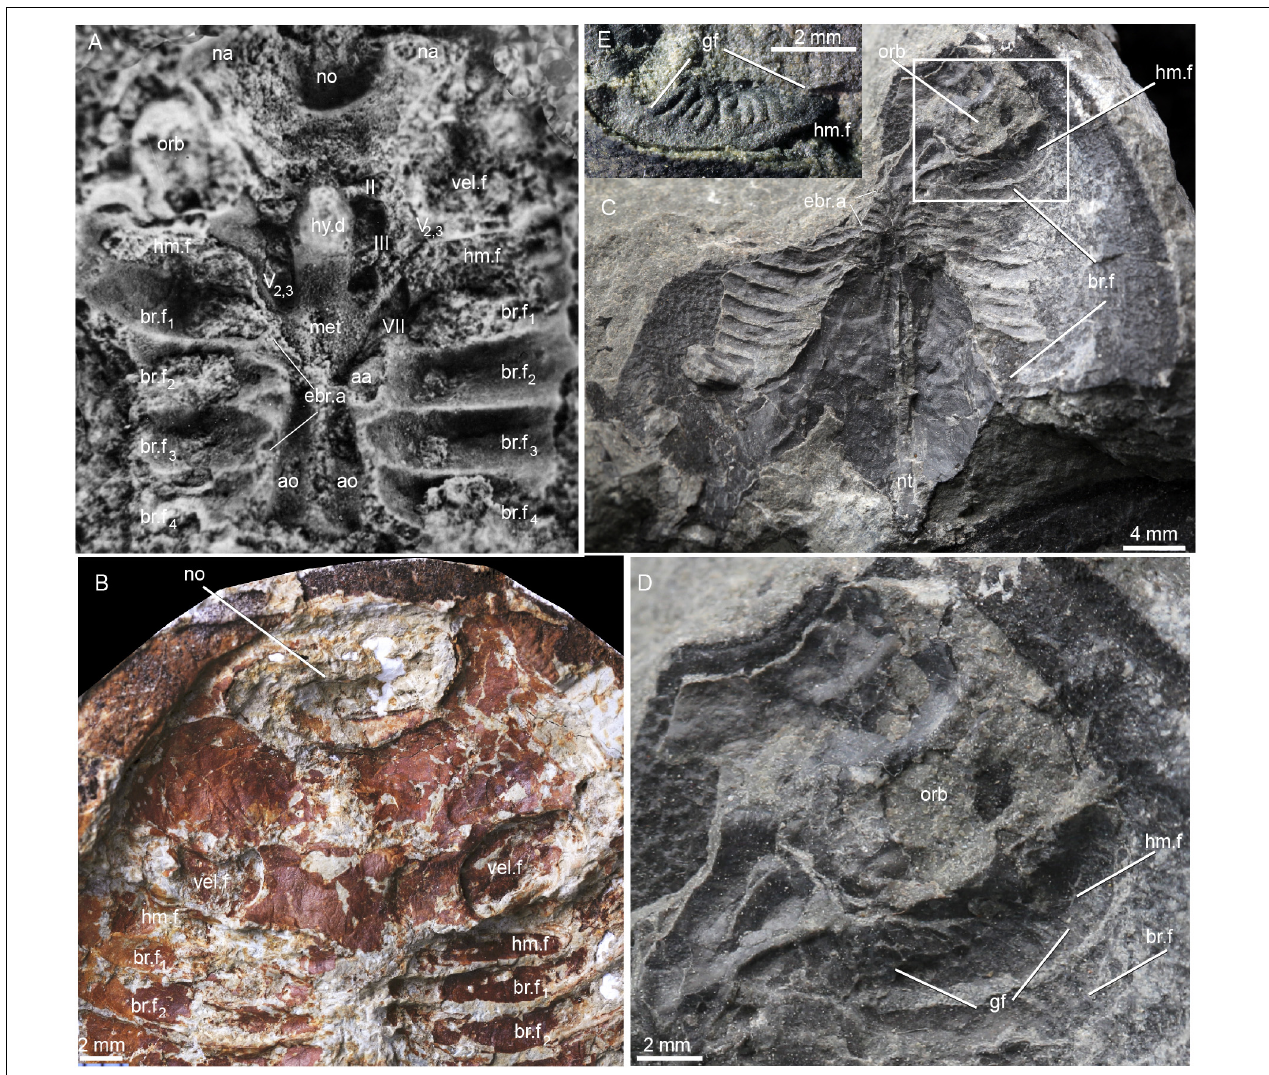
FIGURE 3 | Natural casts of oralobranchial chamber in galeaspids. (A) Natural cast of oralobranchial chamber of Shuyu zhejiangensis , specimen V14334.13B, showing a complete hyomandibular fossa ( hm.f ), four branchial fossae ( br.f ), paired grooves for dorsal aorta ( ao ), a middle ridge for the notochord ( nt ), the nasopalatine component of trigeminal nerve ( V 2 , 3 ) innervates the first interbranchial ridge for the mandibular arch ( ma.a ) and the facial nerve ( VII ) innervates the second interbranchial ridge for the hyoid arch. (B) Natural cast of oralobranchial chamber of Polybranchiaspis liaojiaoshanensis , specimen V3027, in ventral view, showing a large shallow differentiated fossa (vel.f) probably for a velum anterior to the first branchial fossa. (C–E) Natural cast of oralobranchial chamber (C) of a Laxaspis -like galeasids from the Lower Devonian of Qujing showing the impression of gill filaments (D,E) in the hyomandibular pouch (D) . abbreviations as in Figures 1 , 2